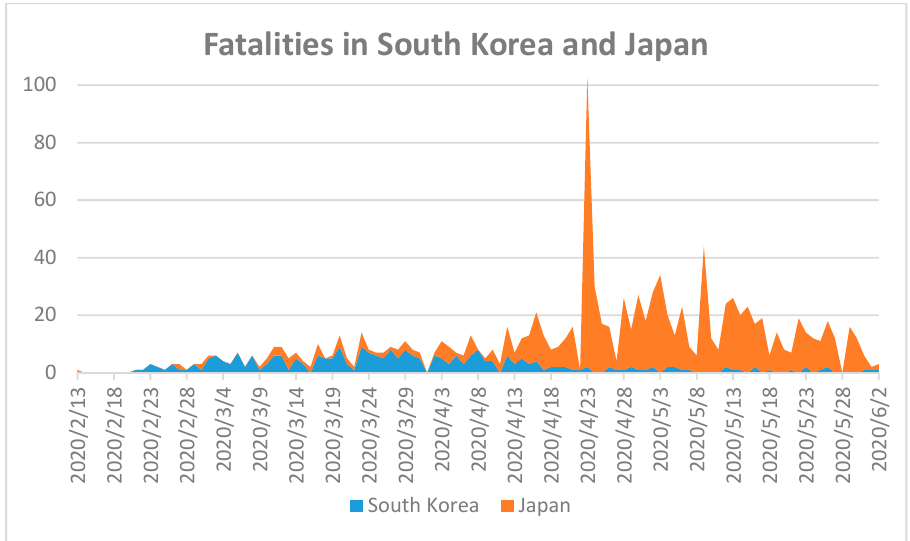
Figure 2. Fatalities during COVID-19 in South Korea and Japan until 2 June 2020 [18]. First fatality in